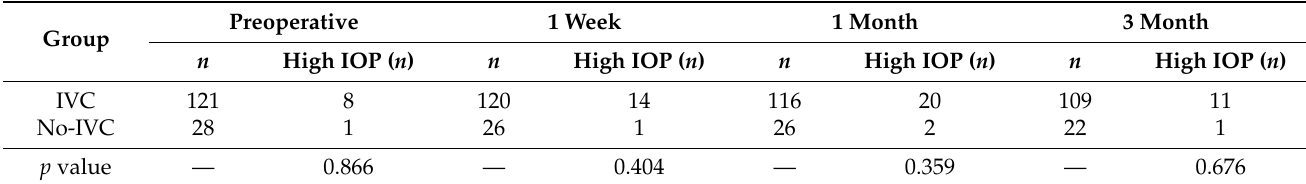
Table 6. The number of patients with ocular hypertension.